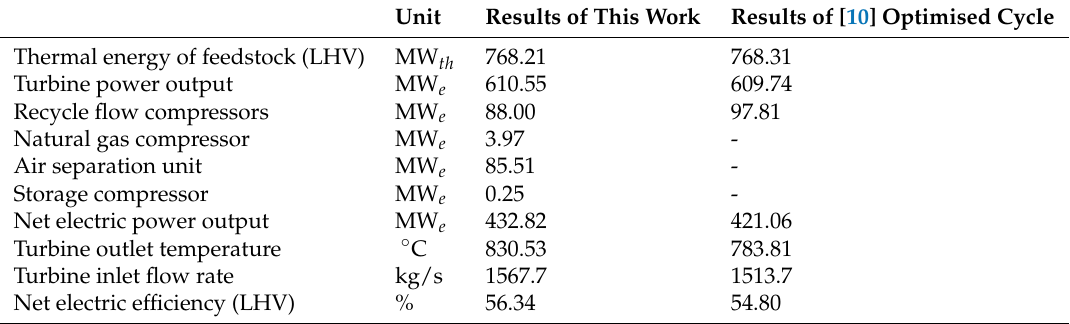
Table 2. Comparison of optimised cycle between [10] and uncooled turbine model. Unit Results of This Work Results of [10] Optimised